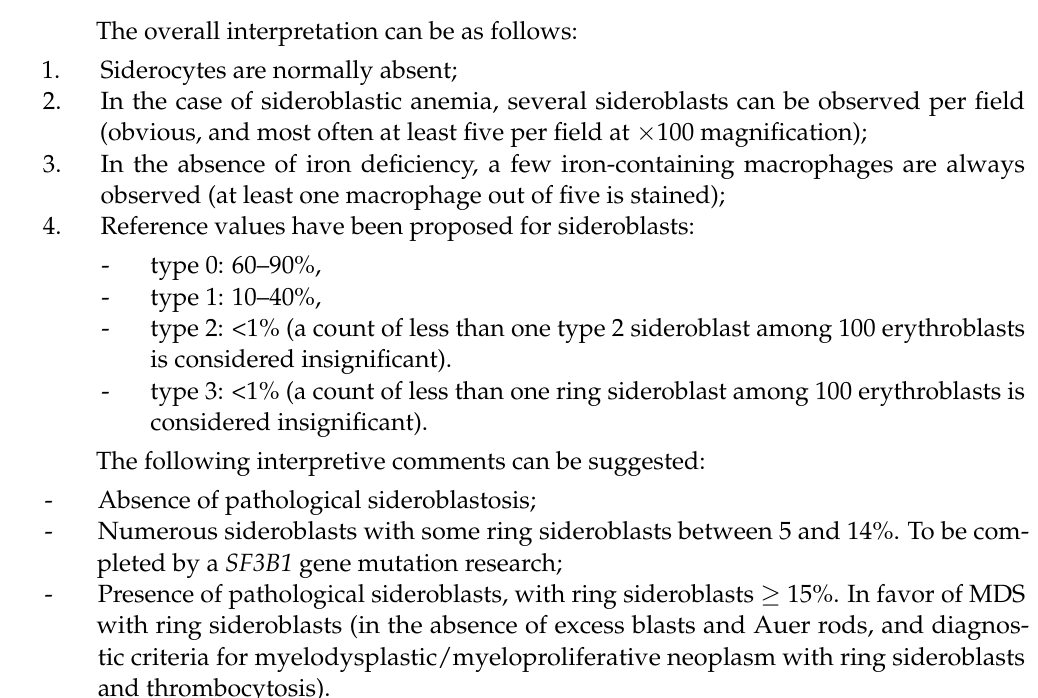
Figure 1. The different types of sideroblasts: (A): Three type 0 sideroblasts, (B,C): One type 1 and one Ring Sideroblast (or type 3), (D): One type 1 sideroblast, (E,F): One type 2 sideroblast, (G,H): One Ring Sideroblast.